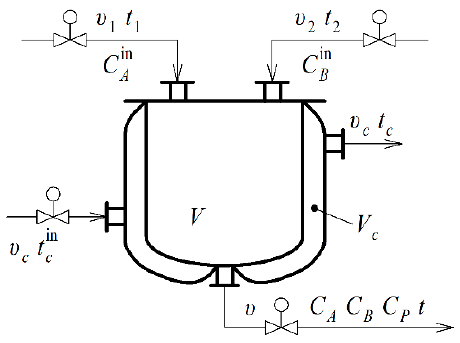
Figure 1. Scheme of the chemical reactor.